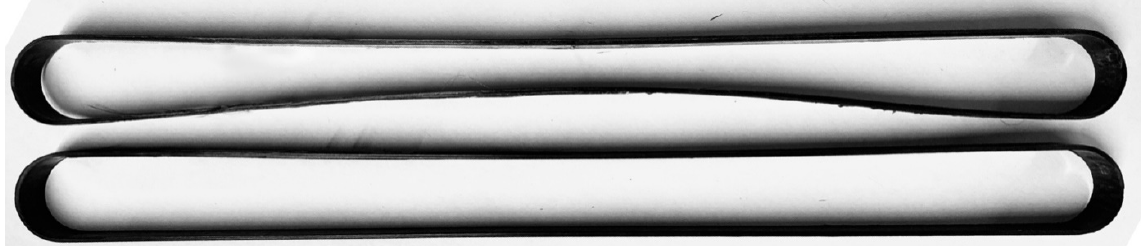
Figure 14. Shape change of prestressed straps ( top ) vs. non-prestressed straps ( bottom ).